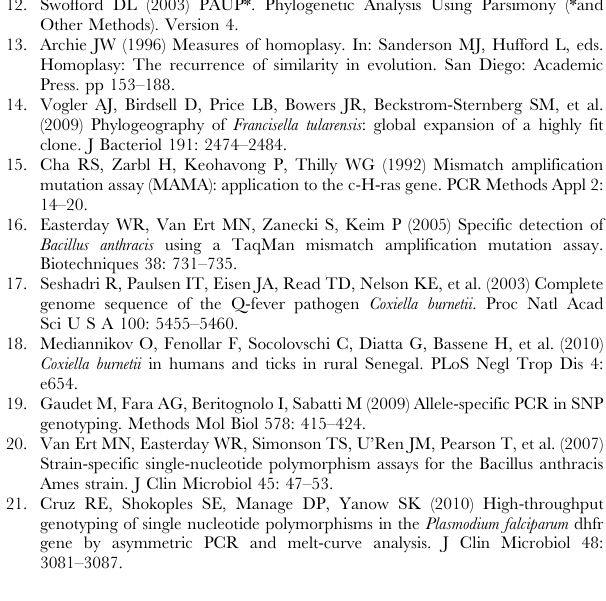
SNP assays presented here. e Vaccine strain. f Sample contained mixed genotypes as determined by both alleles amplifying at four loci. g Allele determined to be homoplastic based on allele calls at the 13 other loci. Abbreviations and symbols: WGS, Whole genome sequences where sequences and epidemiological data were used from http://www.ncbi.nlm.nih.gov and SNP data was derived using in silico techniques; EP, egg passage; -, epidemiolog- ical data is missing or unknown; ?, alleles were absent when genotyped using in silico methods; u, data was undetermined; nt, assay was not